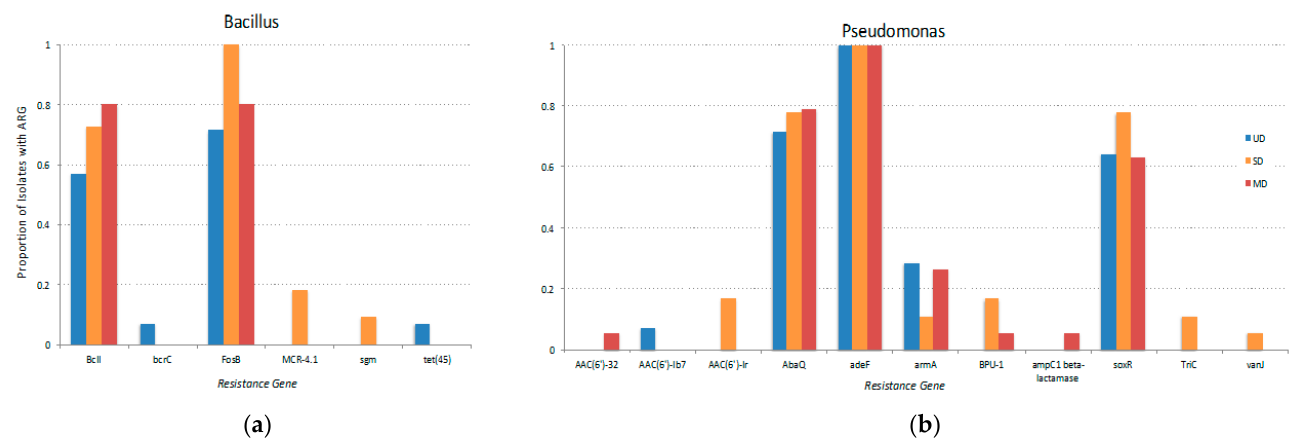
Figure 3. ( a ) Boxplot displaying the number of antibiotic resistance genes per isolate by phylum (Kruskal-Wallis p = 2.8 × 10 − 13 ) with points representing an isolate color-coded by FPES site. ( b ) Boxplot displaying the number of antibiotic re- sistance genes per isolate by FPES site ((Kruskal-Wallis p = 0.083)) with points representing an isolate color-coded by